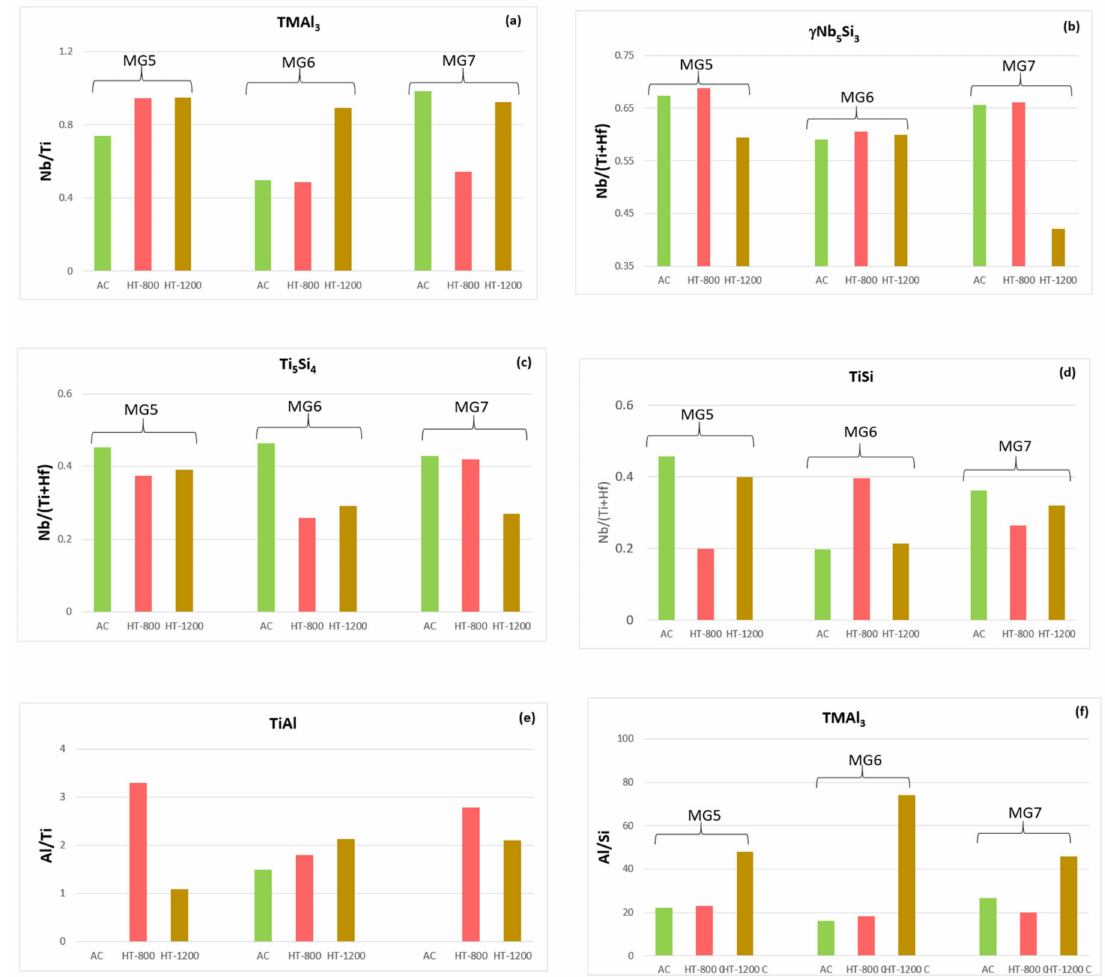
Figure 4. Data about the ratios Nb/Ti, Nb/(Ti + Hf), Al/Ti and Al/Si for different intermetallic compounds observed in the cast and heat treated alloys MG5, MG6 (this study) and MG7 [3], ( a ) TMAl 3 , ( b ) γ Nb 5 Si 3 , ( c ) Ti 5 Si 4 , ( d ) TiSi, ( e ) TiAl, ( f ) TMAl